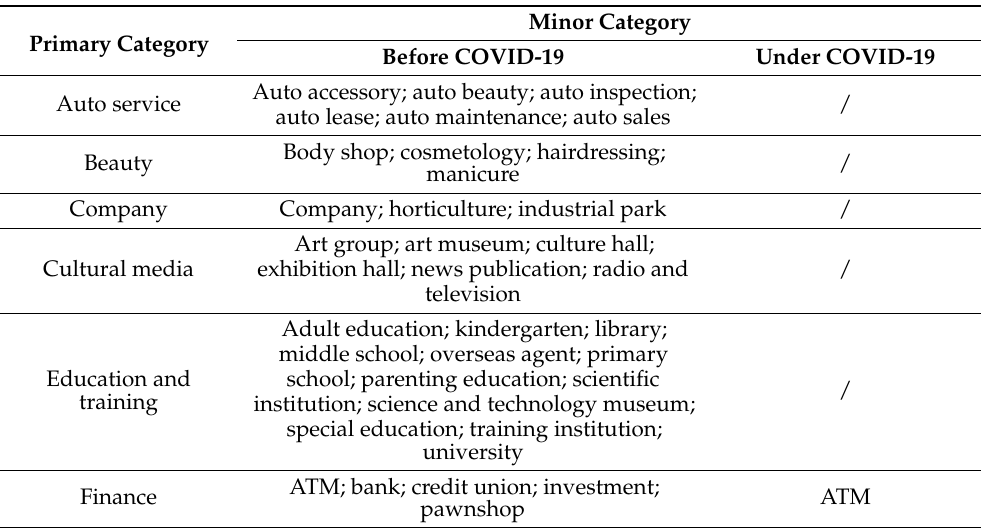
Table 1. POI data before and under the lockdown of COVID-19 in